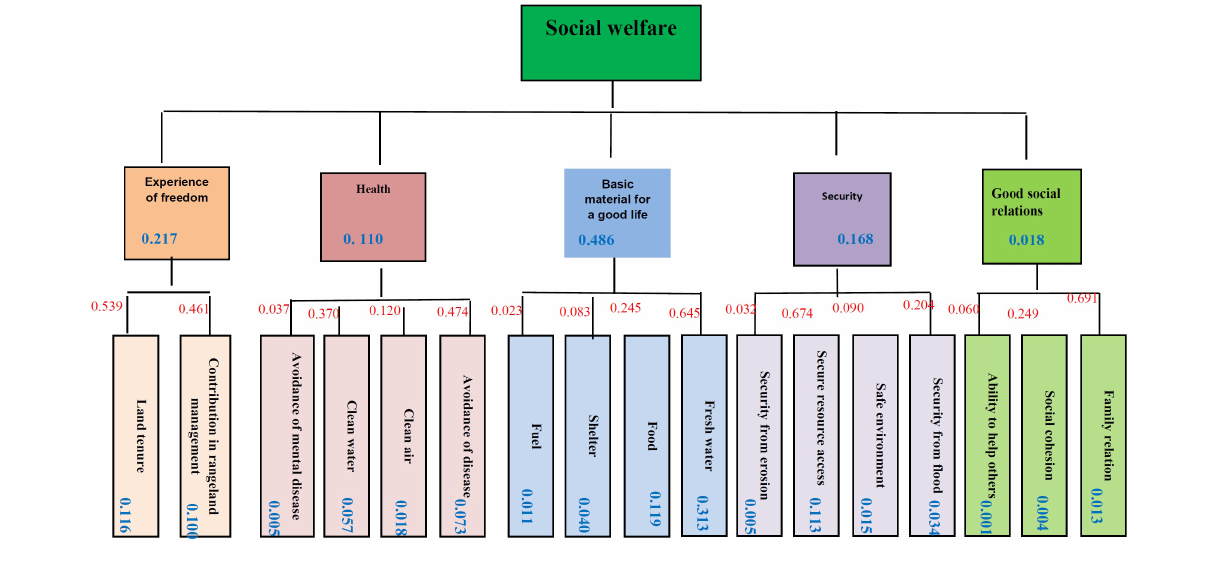
FIGURE 4 | Well-being indicators and indices in the decision tree of the analytic hierarchy process (AHP). Blue numbers are the weights of the indicators and indices for well-being; red numbers are the weights of the indices for each